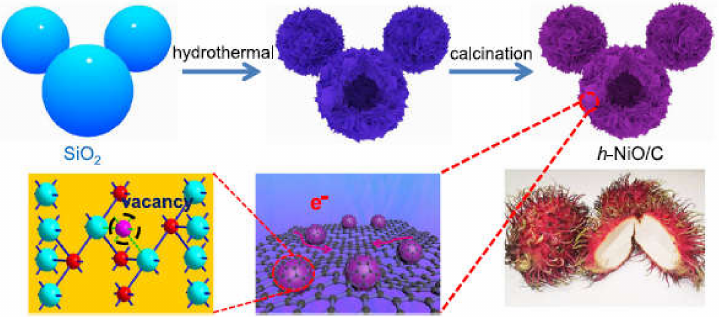
Figure 3. The fabrication process of h -NiO/C. The as-prepared h -NiO/C sample with abundant oxygen vacancies looks like a rambutan shell. Inset: a photo of rambutans. Copyright 2019 by Wenzhou University and John Eiley andSons Australia, Ltd.